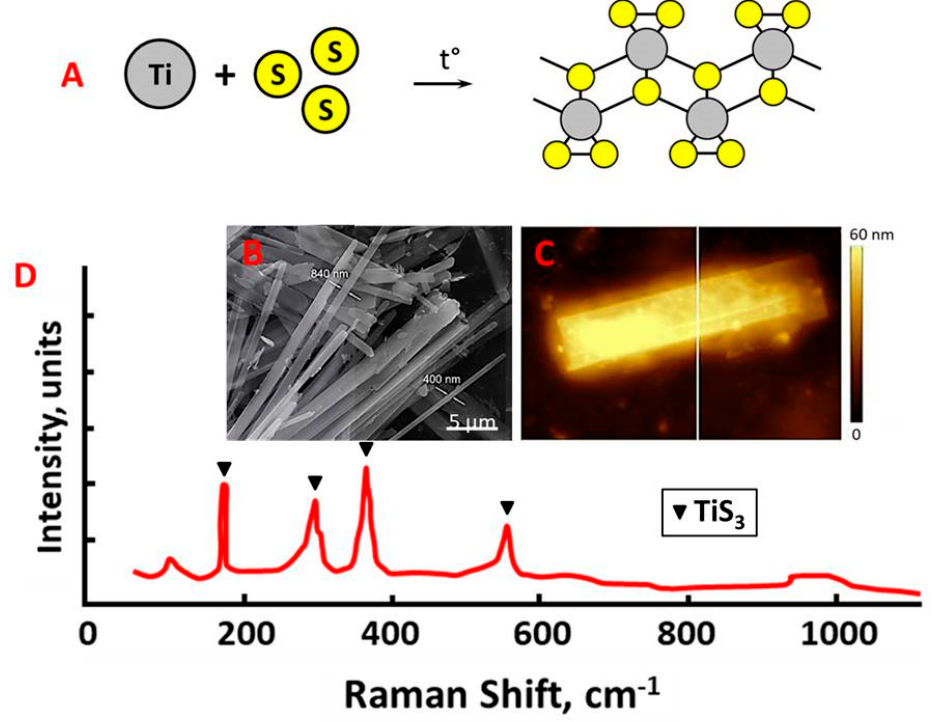
Figure 1. TiS 3 nanoribbons synthesis and sample characterization: ( A ) reaction scheme, ( B ) SEM image, ( C ) AFM image, ( D ) Raman spectra.